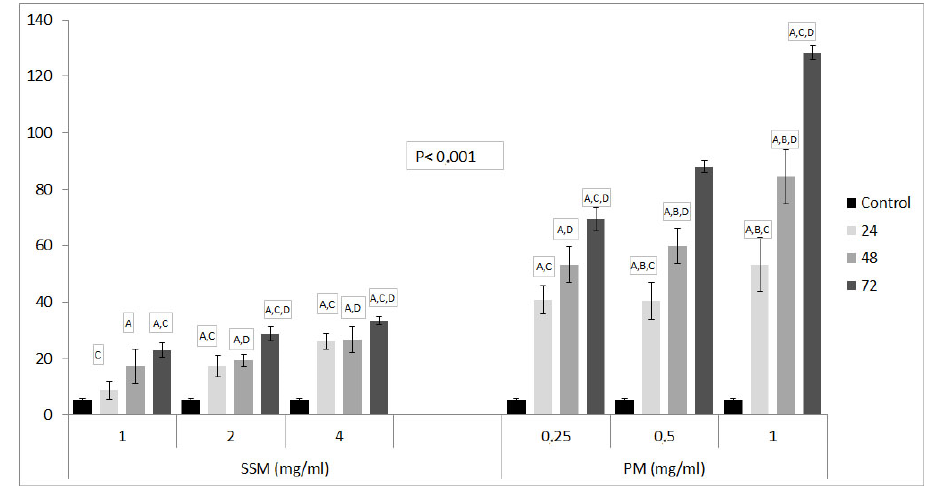
Figure 6. The comet assay results of SSM and PM on L-929 cell lines. Values are shown as Mean ± SD, which, are three separate experiments, performed in triplicate. Data are representative of tree independent trials and are expressed as the mean ± SD. Significant differences between DNA damage at 24, 48 and 72 h were indicated by p < 0.05 as: A: Significant differences between DNA damage of control and related Nano-micelles at indicated incubation periods, B: Significant differences between DNA damage of 24 h incubated cells and 48 h incubated cells, C: Significant differences between DNA damage of 24 h incubated cells and 72 h incubated cells, D: Significant differences between DNA damage of 48 h incubated cells and 72 h incubated cells with related Nano-micelles.